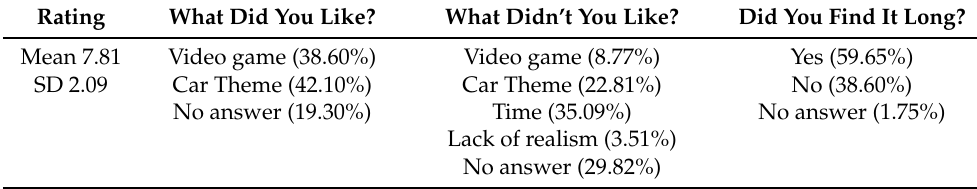
Table 1. Results of the satisfaction questionnaire on the car driving